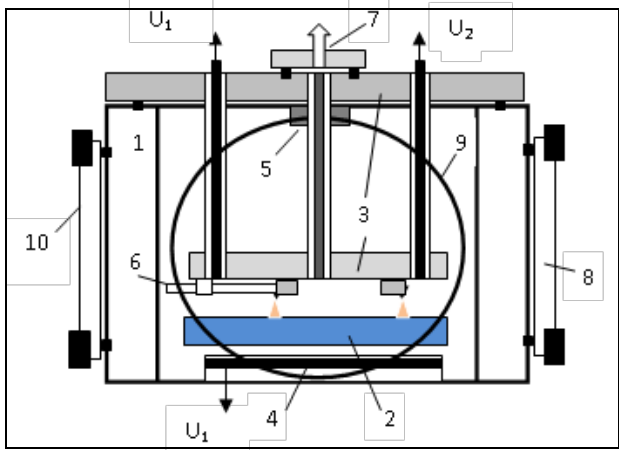
Figure 1. 1 - discharge chamber made of plexiglass, 2 - a cuvette with a non-metallic liquid (diameter - 120 mm, height - 16 mm), 3 - platforms with an electrode system “blade-surface of non-metallic liquid-blade”, 4 - grounded metal plate, 5 - system adjusting the height of the electrodes above the surface of the liquid (h = 0-15 mm), 6 - the system for regulating the distance between steel blades (L = 40-80 mm), 7 - the system for pumping out and gases inlet, filling the cuvette with liquid and adjusting the system of electrodes in height, 8 - quartz window for recording spectra and radiation from the plasma discharge gap, 9 -